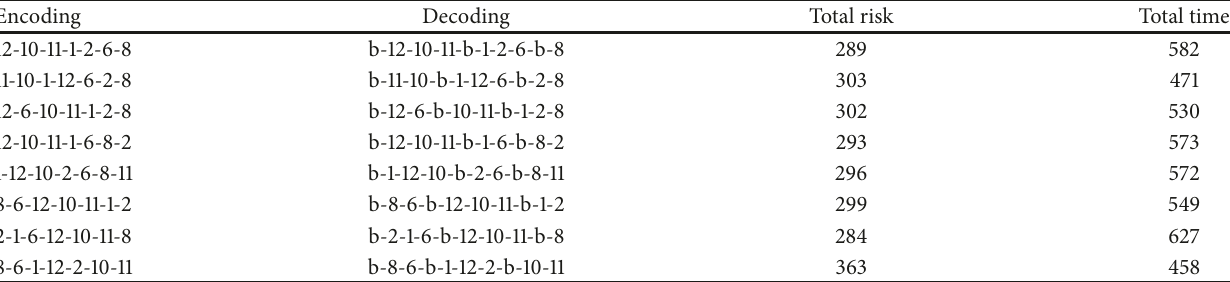
Table 8: Pareto solution set of robust control parameters Γ =0 for distribution center b.